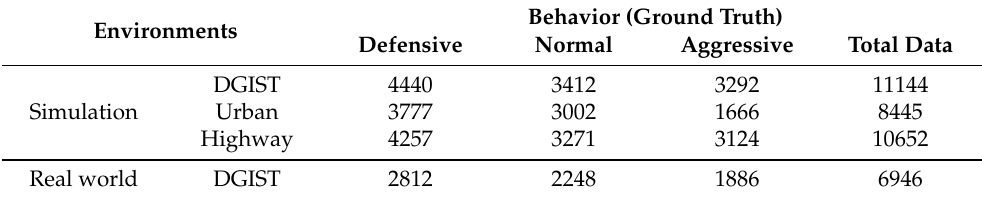
Table 3. Number of data assigned to labels in the test dataset.